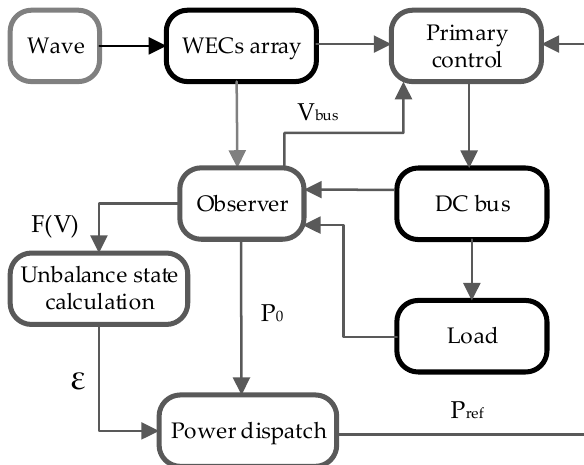
Figure 7. Power dispatch procedure of WECs array.